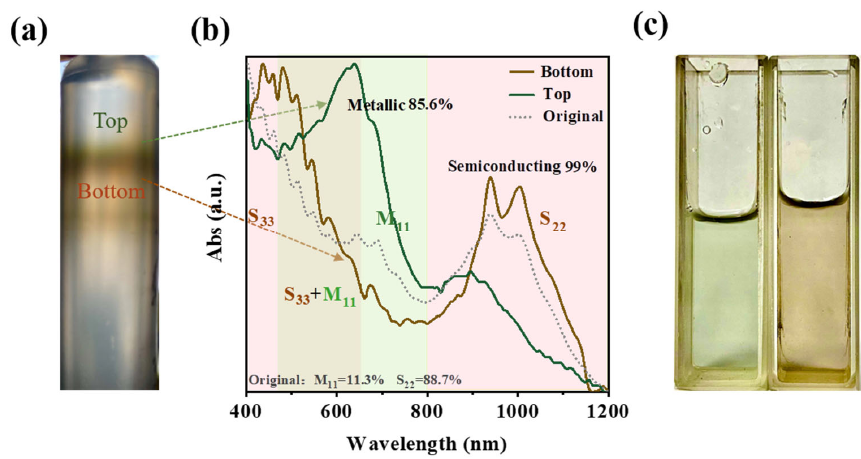
Figure 5. ( a ) Photograph of the centrifuge tube after DGU, ( b ) optical absorption spectra of the top green layer, the bottom red–brown layer, and BA–PMS dispersed SWNTs, ( c ) photograph of the solutions collected from the top green layer (left) and the bottom red–brown layer (right).